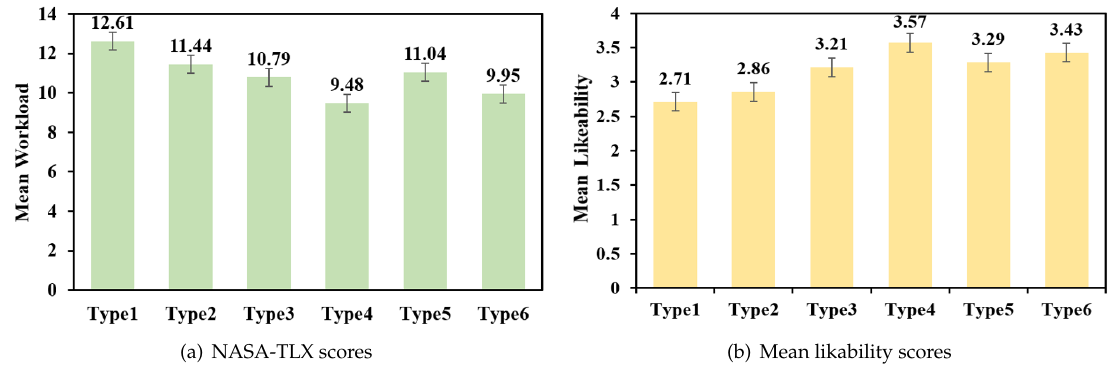
Figure 13. The NASA-TLX workload scores ( a ) and mean likability scores ( b ) for 6 different placement modes.